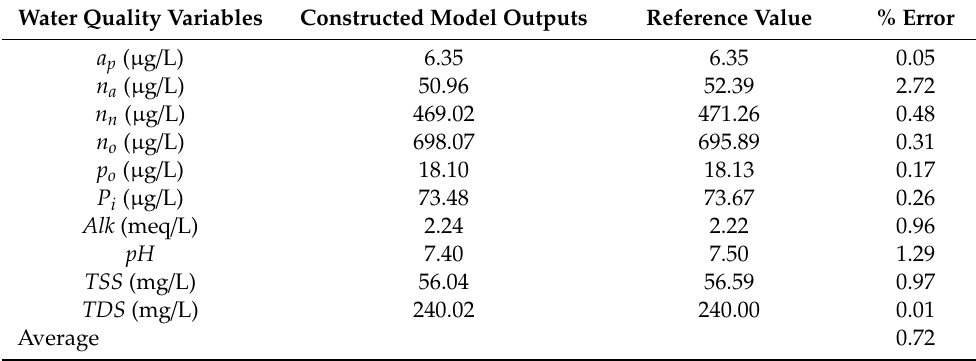
Table 8. Calibration with Qual2k for channel length 5000 m.